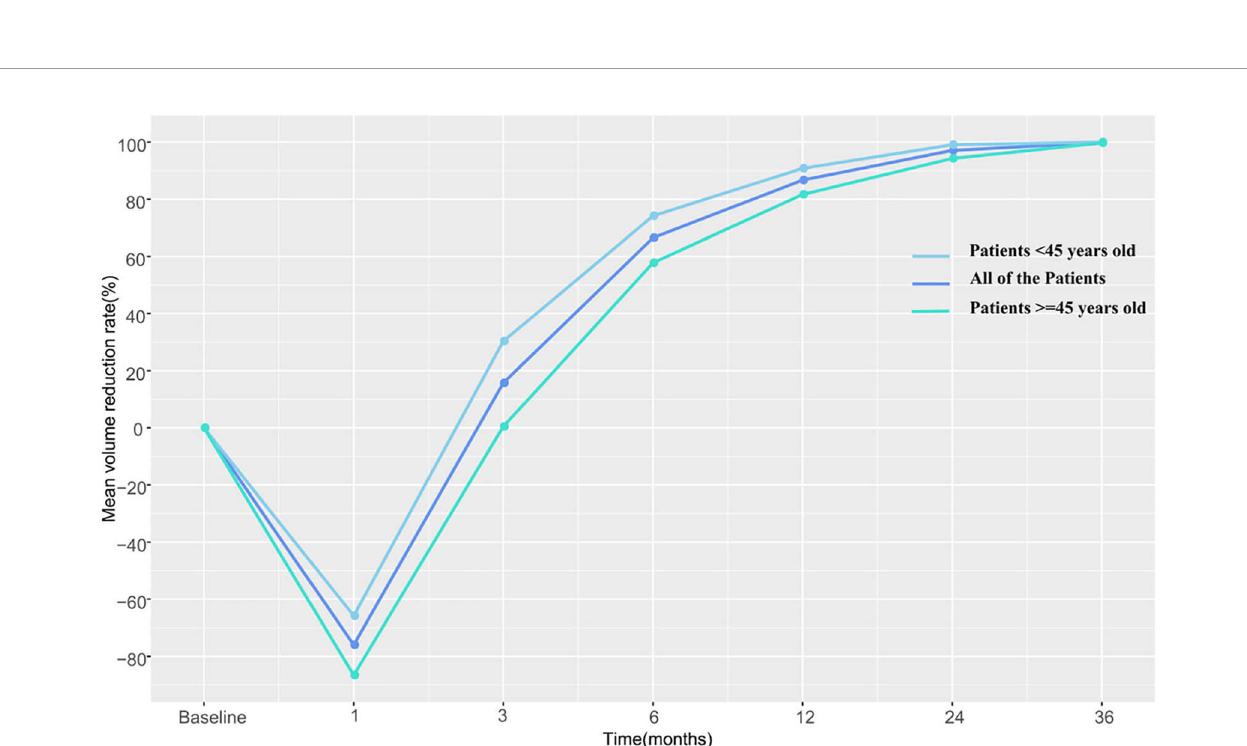
FIGURE 3 | The changes in volume reduction rate at each follow-up point in both age subgroups.